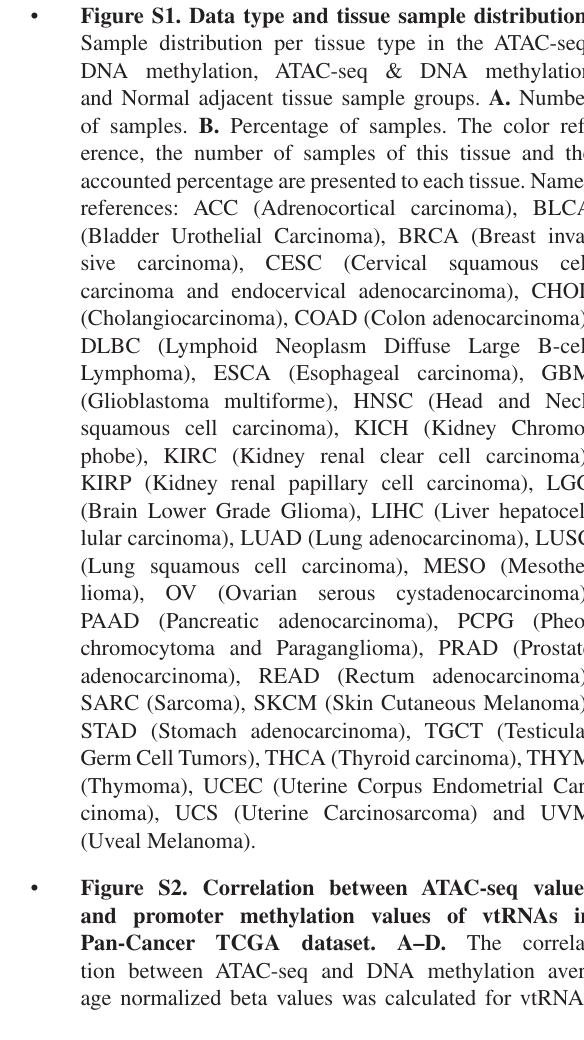
Figure S1. Data type and tissue sample distribution. Sample distribution per tissue type in the ATAC-seq, DNA methylation, ATAC-seq & DNA methylation and Normal adjacent tissue sample groups. A. Number of samples. B. Percentage of samples. The color ref- erence, the number of samples of this tissue and the accounted percentage are presented to each tissue. Names